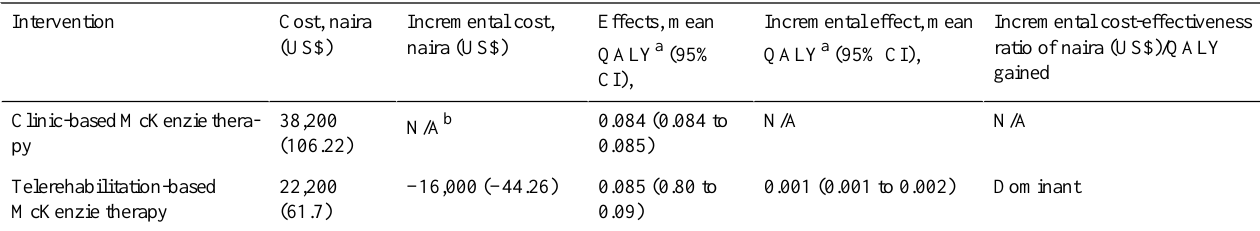
Table 3. Estimates of clinical effectiveness at weeks 4 and 8 after